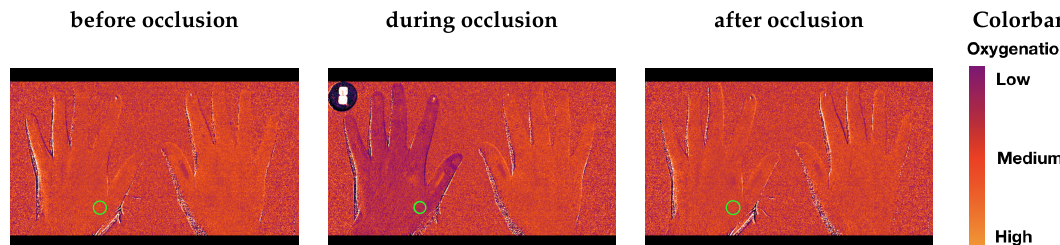
Figure 11. Colormaps of the three different stages of the occlusion before the occlusion ( left ), during the occlusion shortly before the deflation of the cuff ( middle ), reperfusion after the cuff is released ( right ). Green circle indicating the averaged region of interest for oxygenation